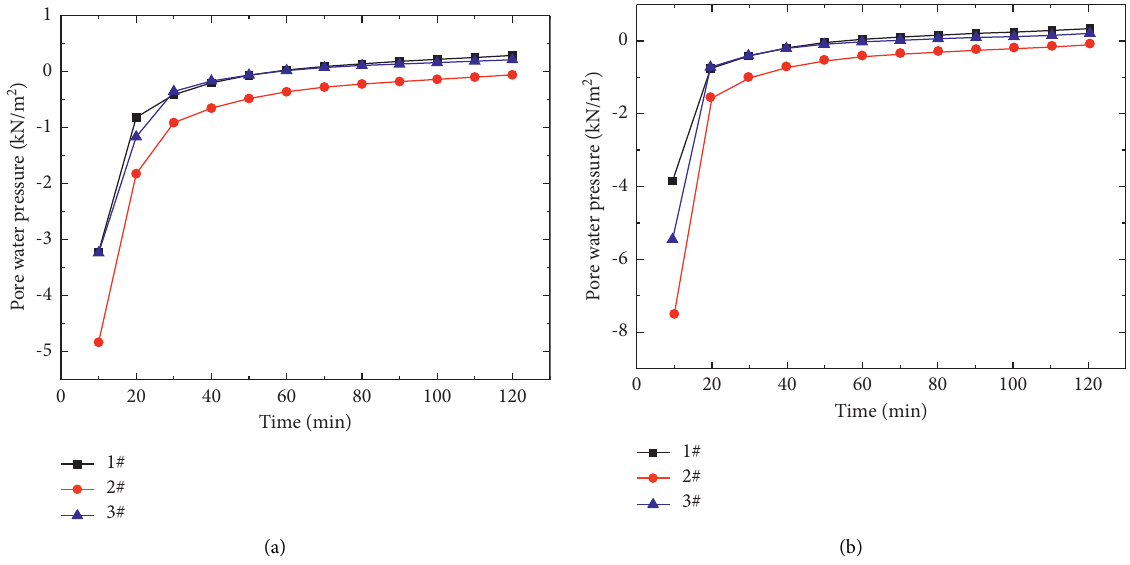
Figure 22: Pore water pressure at observation points 1–3 of (a) building 1 and (b) buildings 2–4 with seepage wells placed around building 1 in the numerical